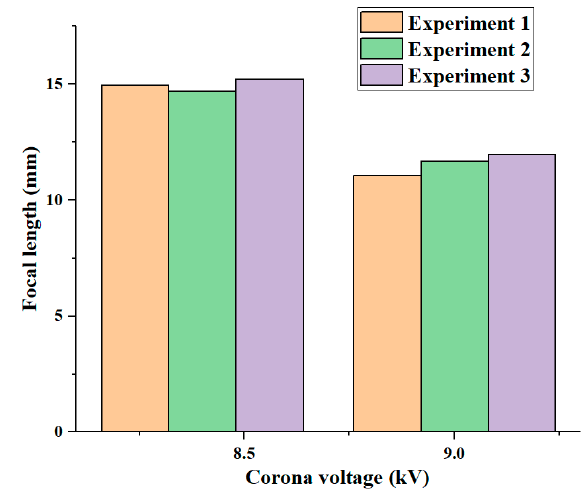
Figure 10. Focal length at two different voltages in three repeated experiments.